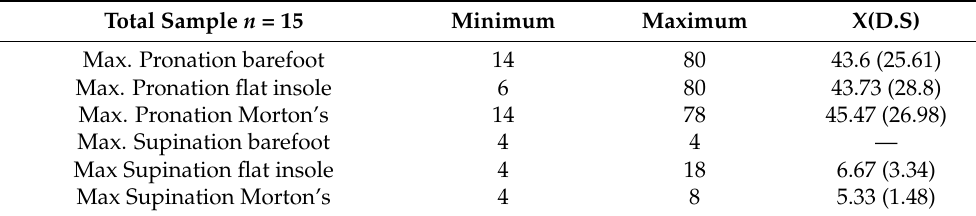
Table 2. The pronation and supination moments with respect to the footwear, the footwear with a flat insole and the footwear with a Morton’s extension situation is shown. The measures are shown in Newton for a 95% confidence interval; a normal distribution of the variables is presented. (Fx